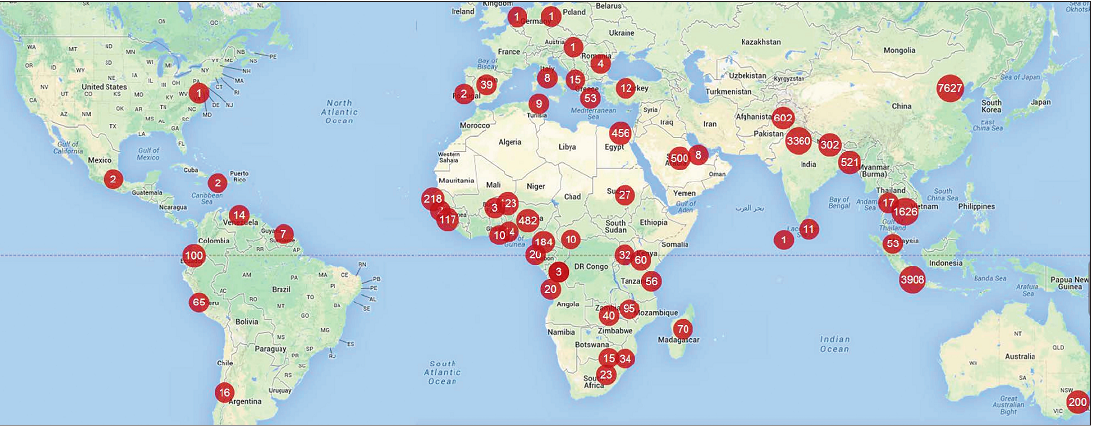
Figure 10. Worldwide deployment of green cellular BSs [107].